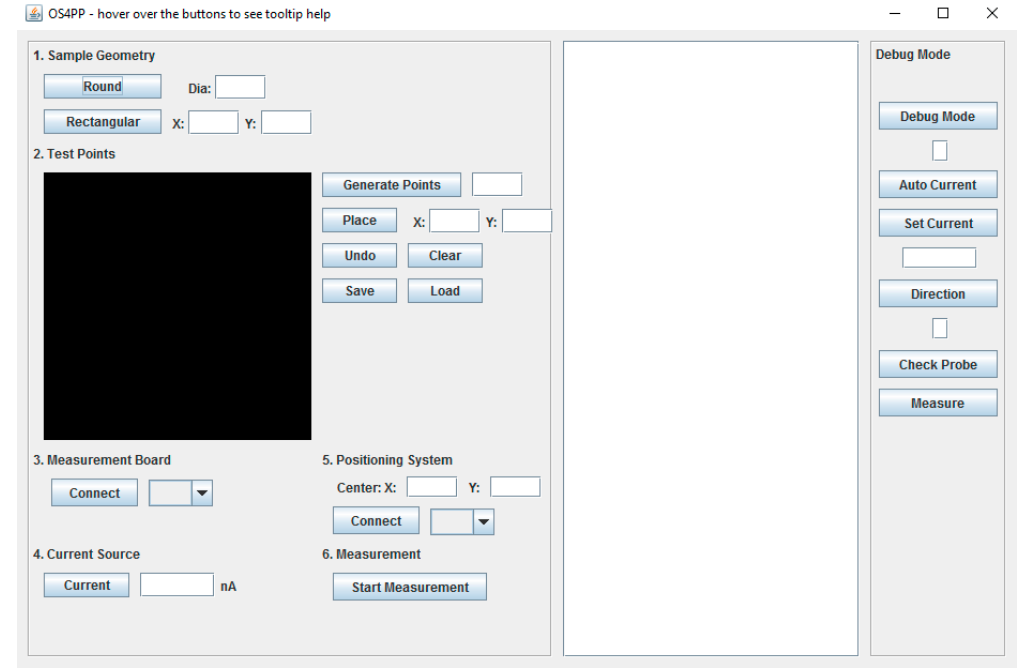
Figure 9. The graphical user interface (GUI) for open source four-point probe (OS4PP) software.